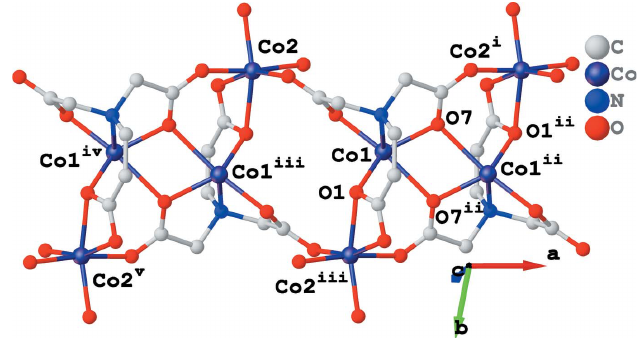
Figure 2 Tetranuclear Co II units and a Co II ribbon in ( I ). Phenyl and meta - positioned carboxylate groups and the disordered lattice water molecules have been omitted for clarity. [Symmetry codes: (i) 1 + x, y, z ; (ii) 1 (cid:4) x , 1 (cid:4) y , 1 (cid:4) z ; (iii) (cid:4) x , 1 (cid:4) y , 1 (cid:4) z ; (iv) (cid:4) 1 + x , y , z ; (v) (cid:4) 1 (cid:4) x , 1 (cid:4) y , 1 (cid:4) z .]